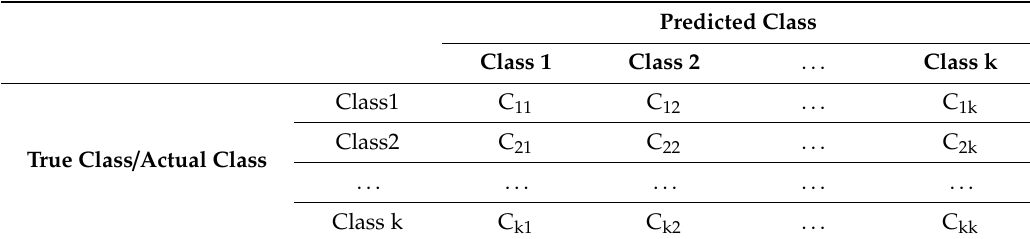
Table 3. Confusion matrix for multi-class